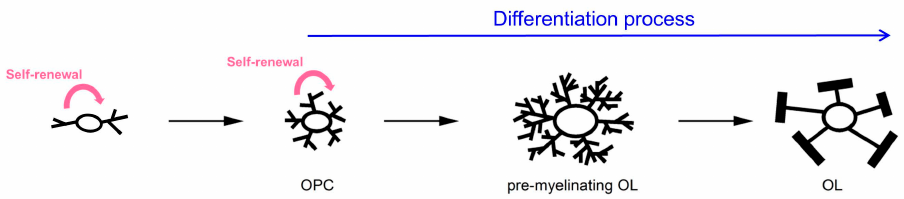
Figure 1. Scheme of the oligodendrocyte lineage cells. Note that early and later OPCs are capable of self-renewal, while more mature OL lineage cells are not.